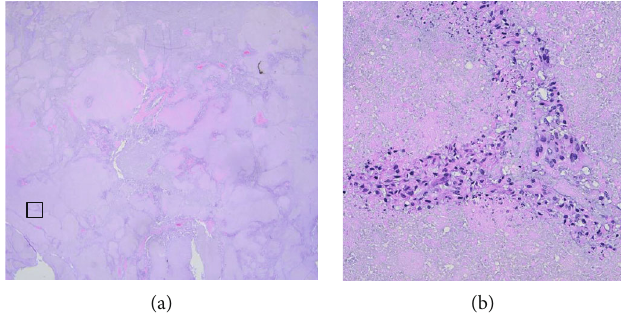
Figure 12: The photomicrograph in (a) is a low-power (X1) image of a representative portion of the lung tumor that had received 8 rounds of treatment with TOL alone over 7 1/2 months. The tissue was taken at the time of necropsy and stained with hematoxylin and eosin. Note the large areas of necrosis that comprise over 90% of the tumor mass. The photomicrograph in (b) is a X40 enlargement of the tissue fi eld de fi ned by the box in (a) that illustrates in greater detail the few blood vessels and neoplastic cells that remained.